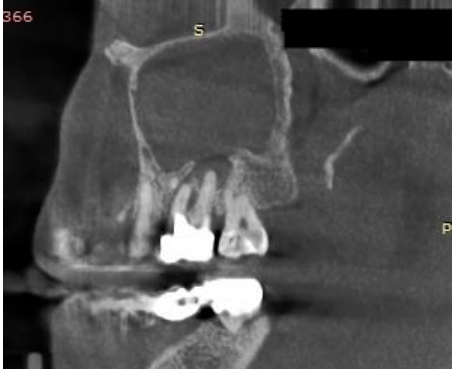
Figure 4. Sagittal CBCT of a patient with odontogenic sinusitis caused by a periapical abscess.